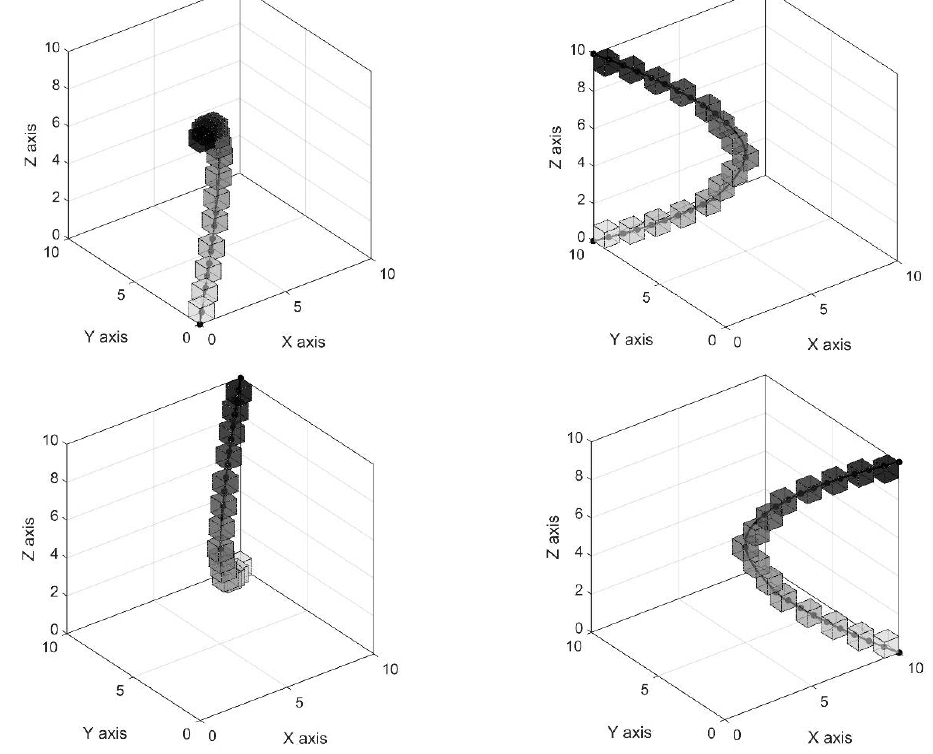
Figure 2. TrajectoryTimeDensity around the four simulated trajectories. Each view shows the time density around a single trajectory.